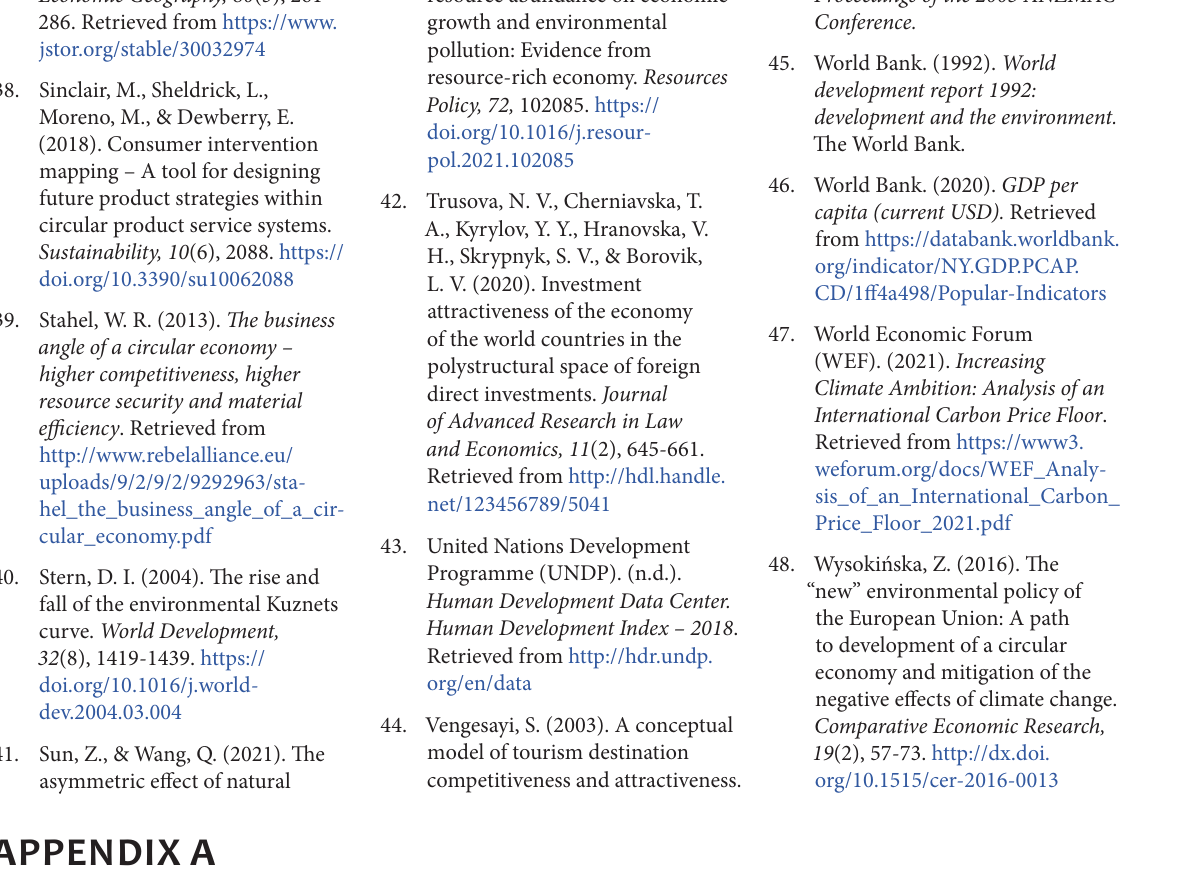
Table A1. Clusters of countries by EPI index Cluster EPI Performance Price level ratio of PPP